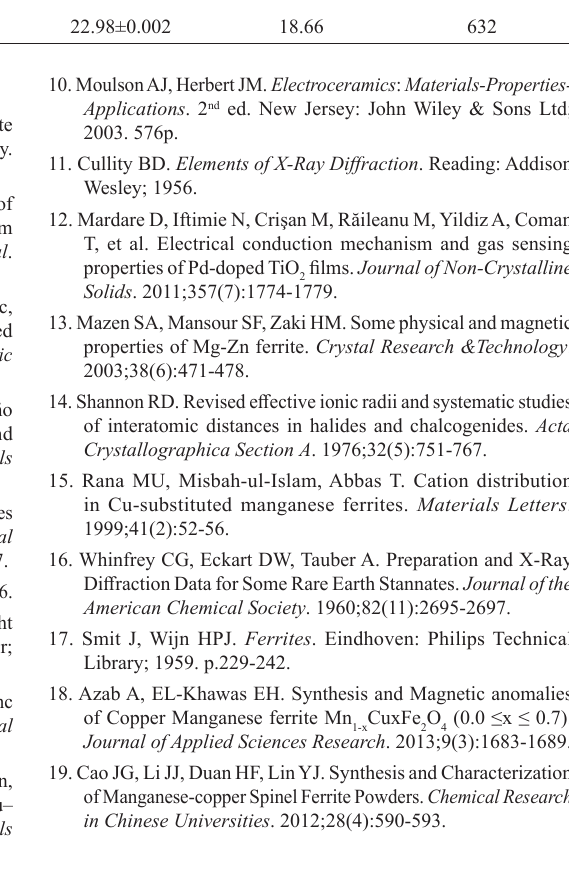
Table 3: Results for the hysteresis measurements of samples Mn